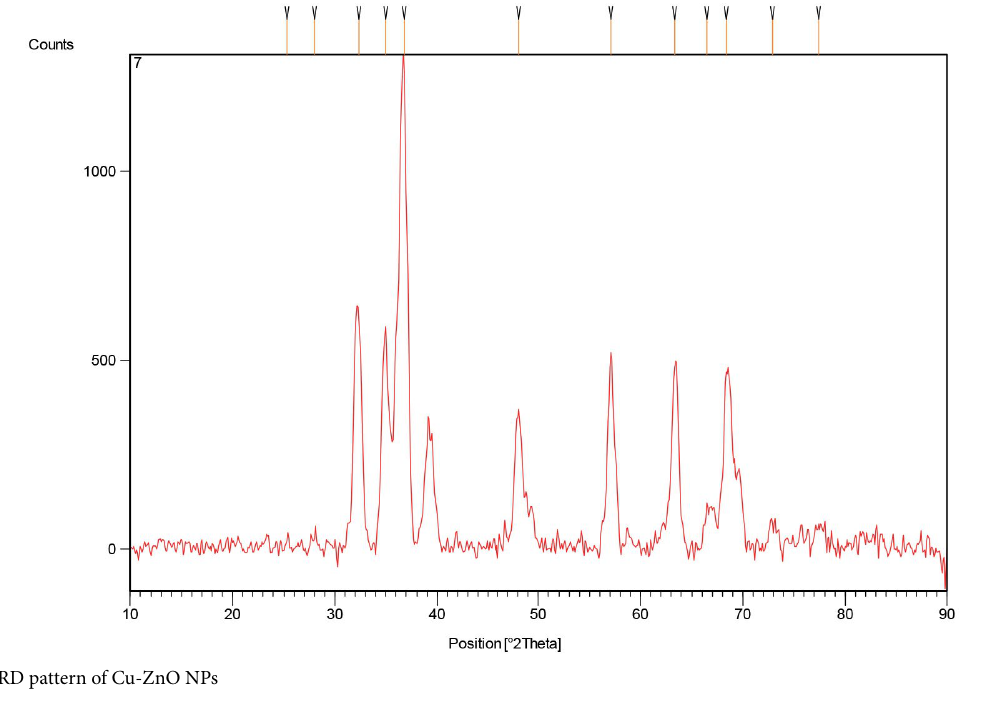
Figure 5. XRD pattern of Cu-ZnO NPs